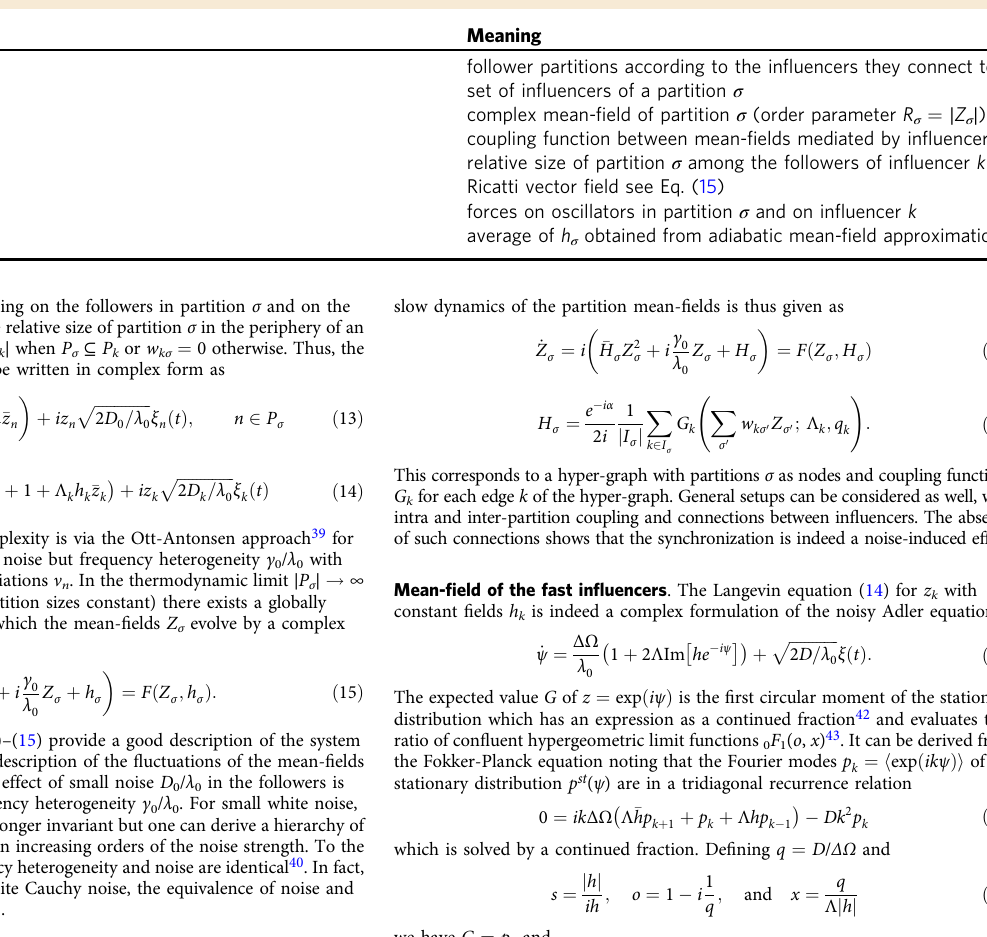
Table 3 Parameters of the mean- fi eld analysis presented in Eq.